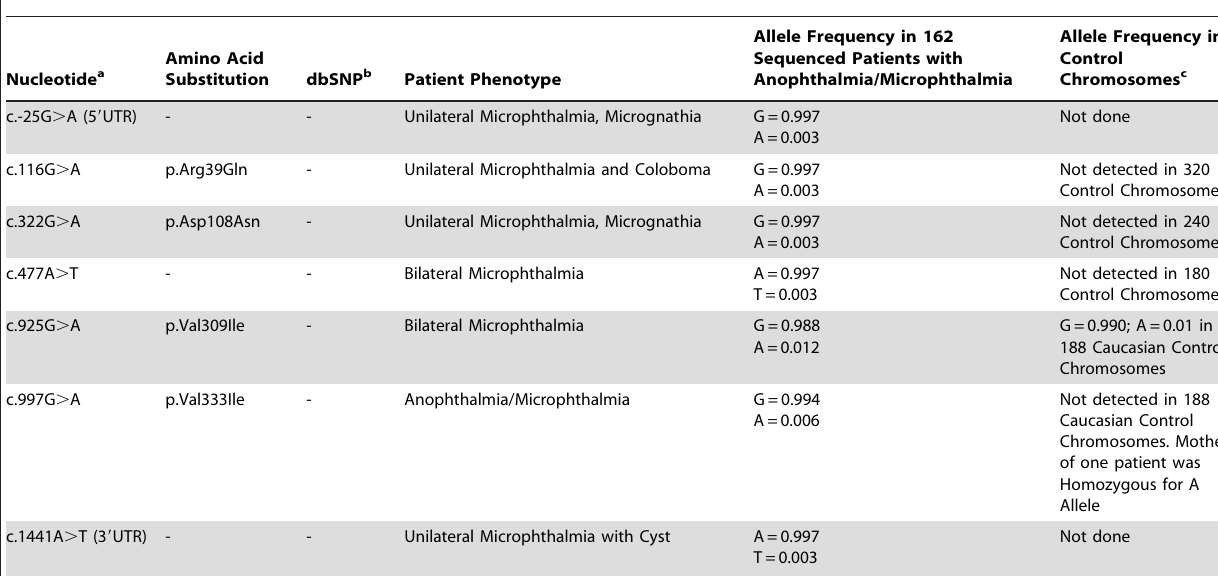
Table 1. Sequence Alterations in TMX3 in 162 patients with Anophthalmia or Microphthalmia.